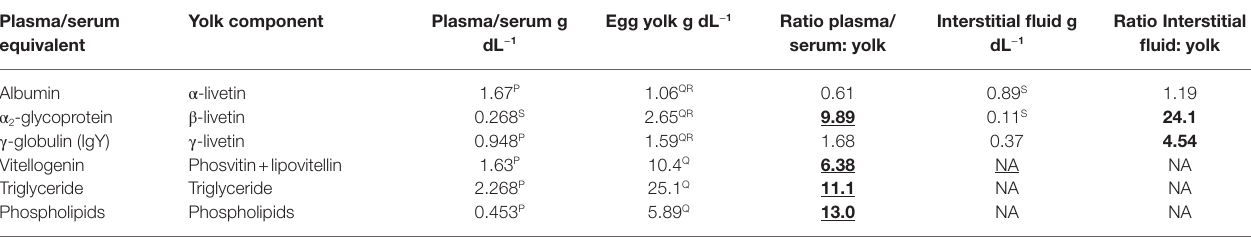
TABLE 3 | Comparison of concentrations of yolk constituents with their concentrations in plasma/serum and egg yolk in chickens. Plasma/serum